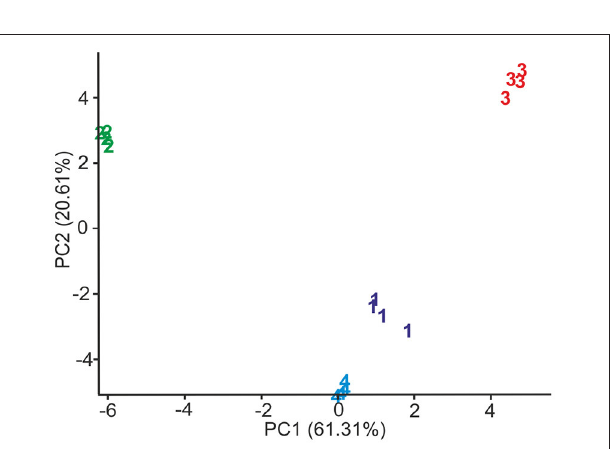
FIGURE 5 | Scores plot of the first two principal components of the PCA model calculated from voltammograms registered when electrodes were immersed in 1: Catechol, 2: Pyrogallol, 3: Vanillic acid and 4: Caffeic acid.